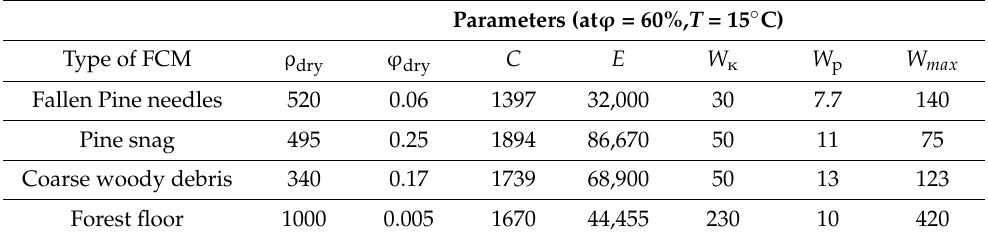
Table 2. Physical properties and moisture content values for some types of FCM.